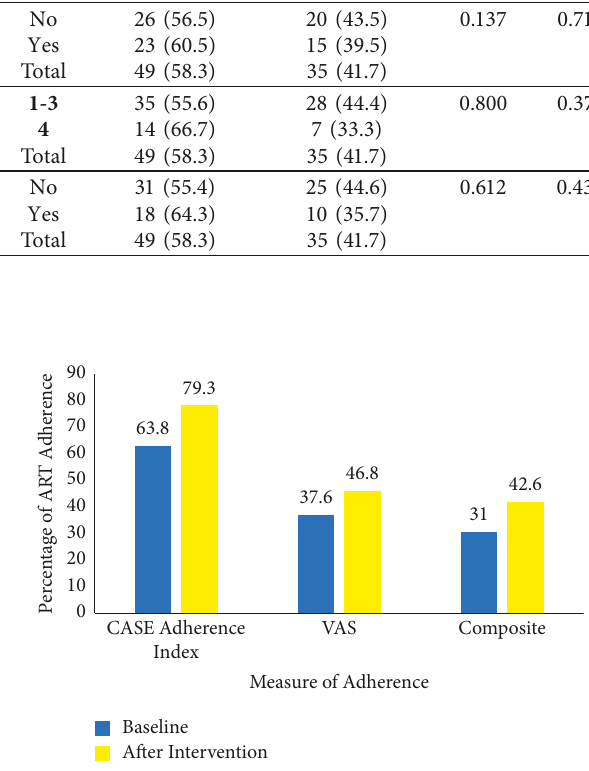
Figure 3: Level of adherence to ARTamong PLWHA as measured by VAS and CASE adherence index at baseline and after the Single way and Double way SMS Intervention. Key: VAS; Visual Analogue Scale, CASE: Center for Adherence Support Evaluation.